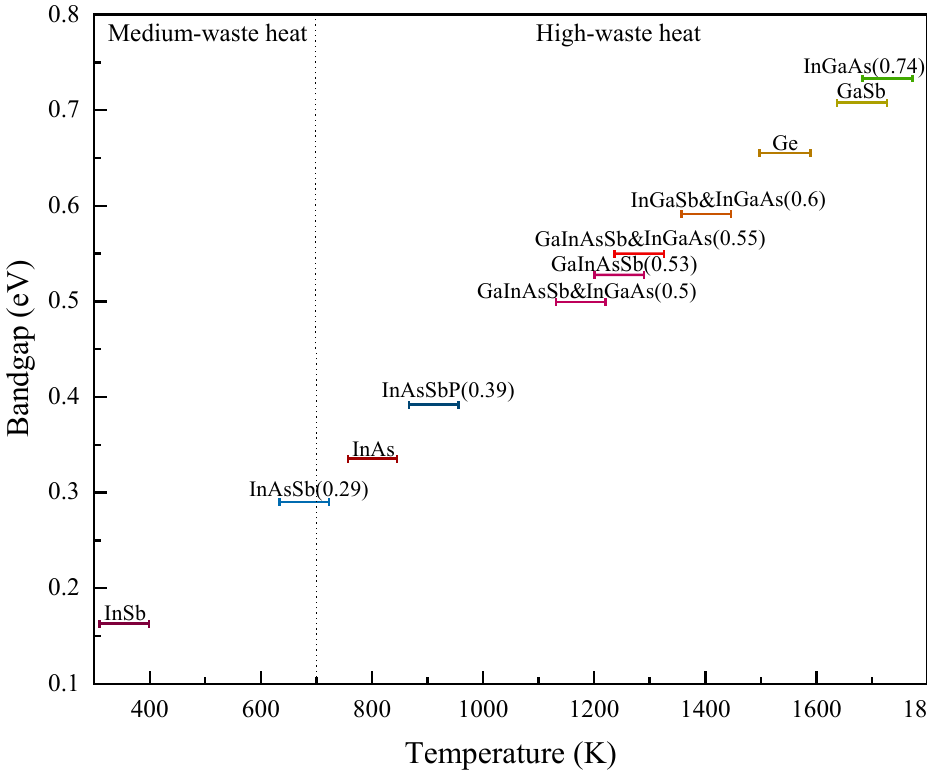
Figure 5. TPV cells and the blackbody temperature range of their optimum performance.